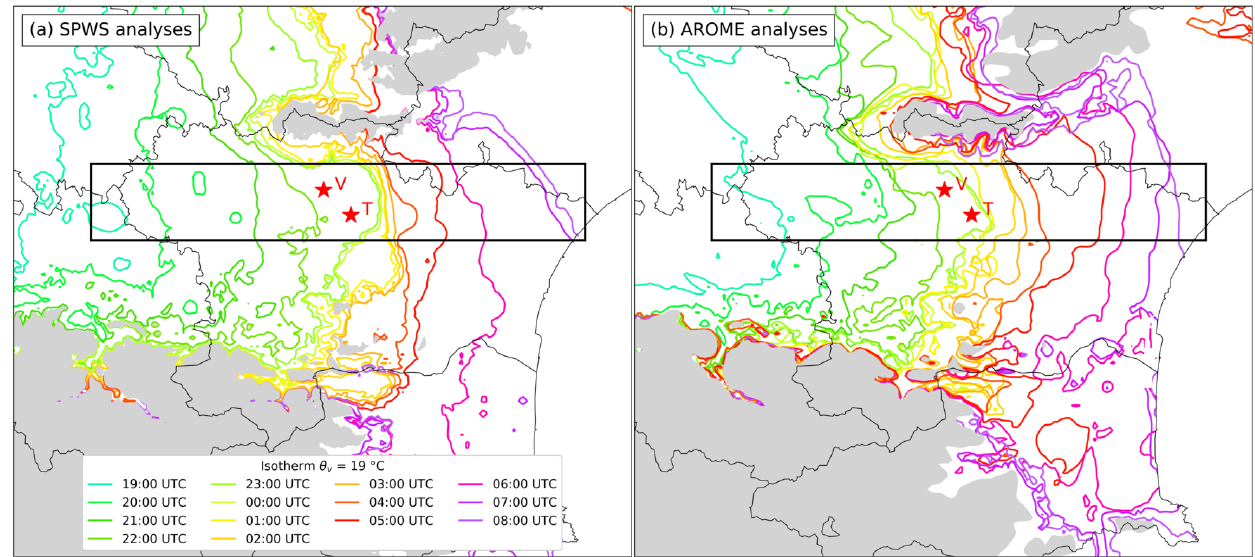
Figure 17. As in Fig. 15 showing the location of the 19 ◦ C 2m virtual potential temperature isotherm, starting at 19:00UTC on 14 October.